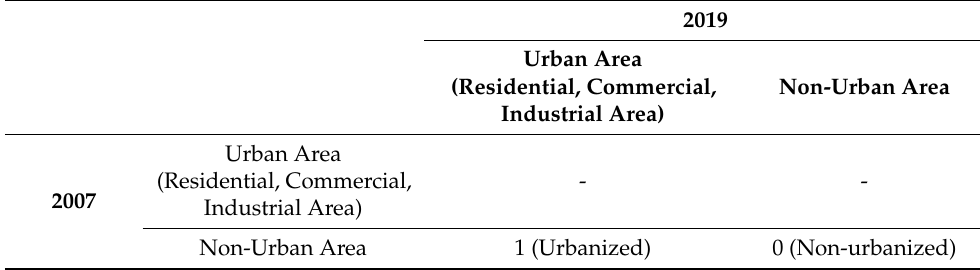
Table 2. Classification of urbanized and non-urbanized